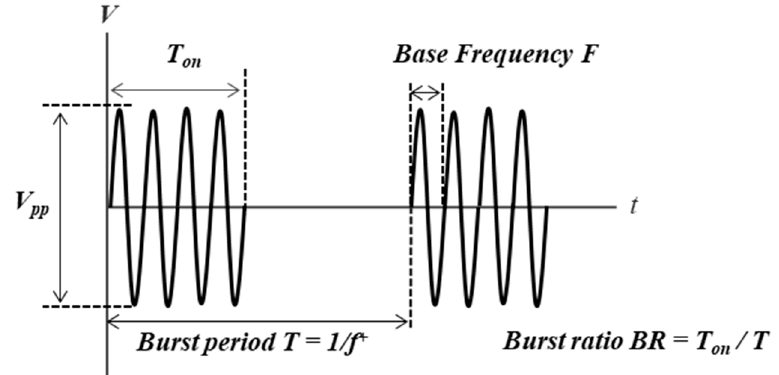
Figure 2. Waveform of burst signal input.